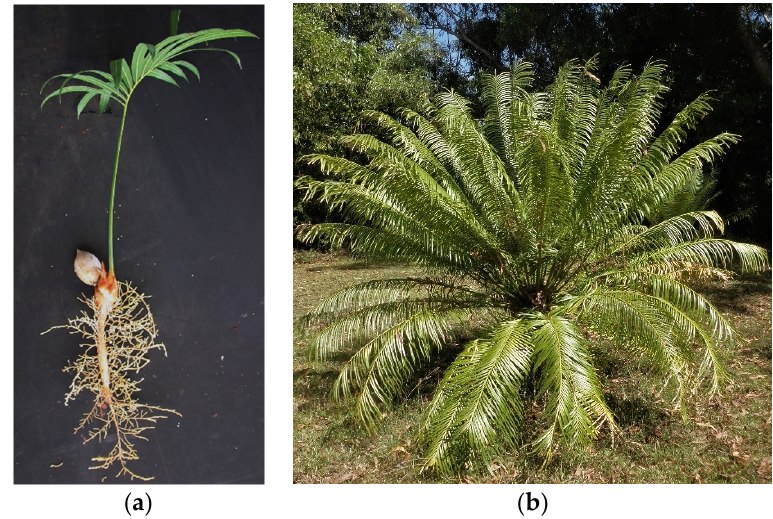
Figure 1. Cycas micronesica plants used in reciprocal garden study on Guam. ( a ) Four-month-old seedling used to establish the gardens; ( b ) Appearance of healthy local genotype after 15 years of growth.